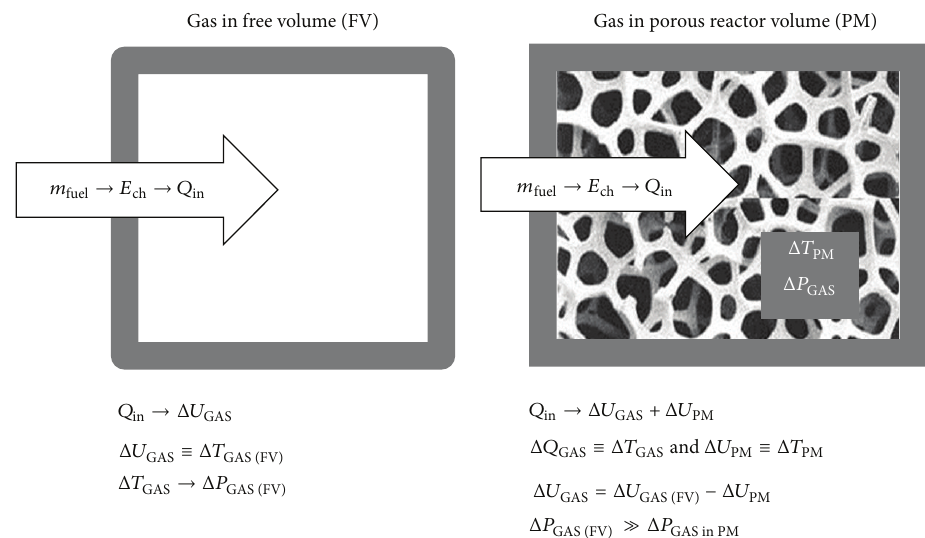
Figure 3: Comparison of thermodynamic conditions in adiabatic free volume system and in porous reactor.